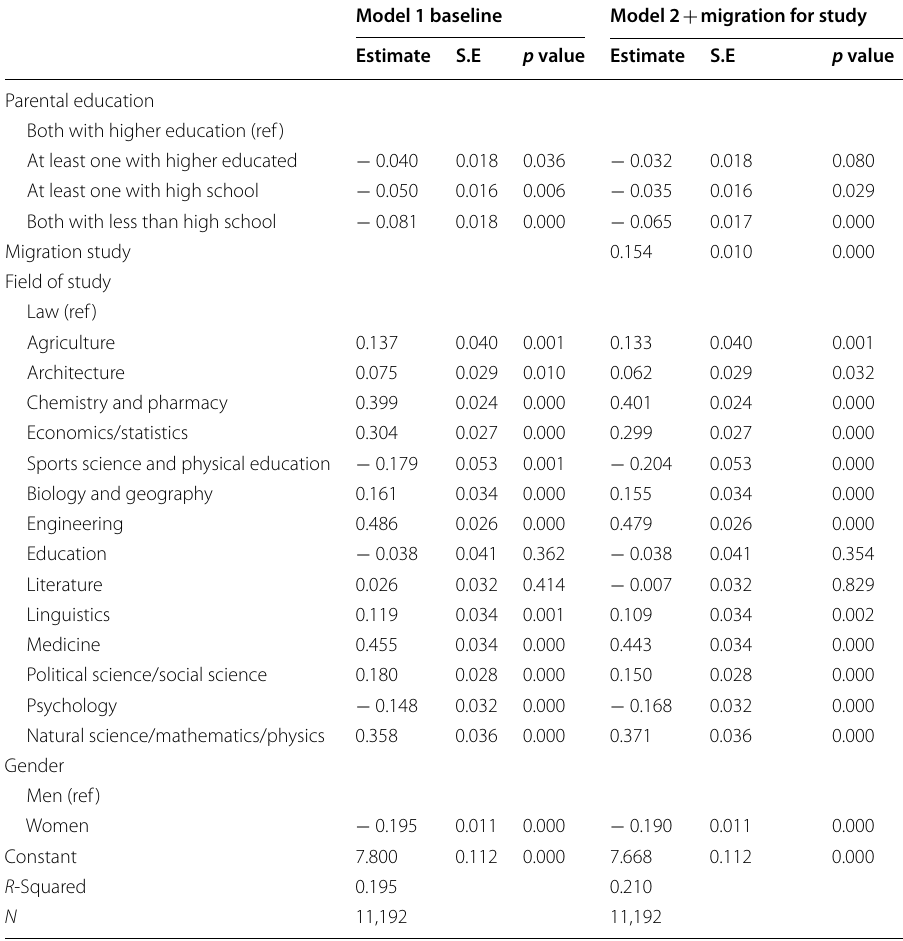
Table 3 Predicting graduates’ income 5 years after